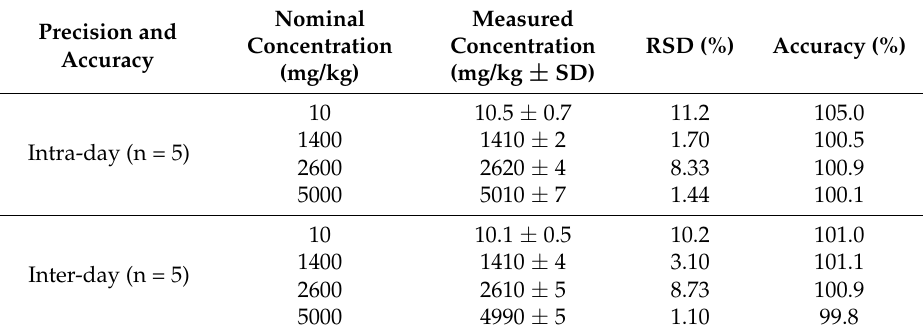
Table 2. Intra-day and inter-day precision and accuracy at different concentrations.